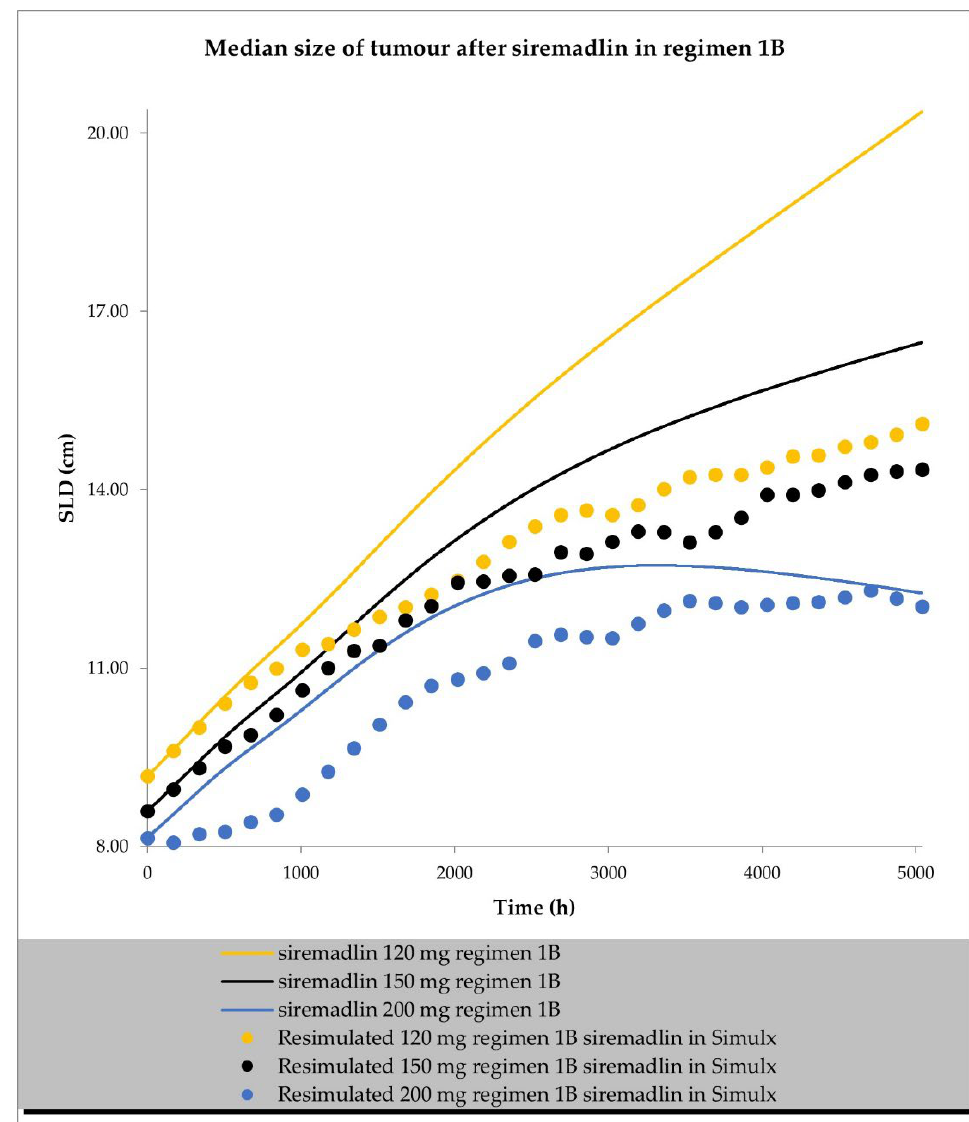
Figure 7. TGI model of siremadlin administered in regimen 1B in cancer patient representatives ( n = 1 per treatment arm). Resimulated data are presented as medians from number of study participants × 10 (see Table 7 in Materials and Methods section).